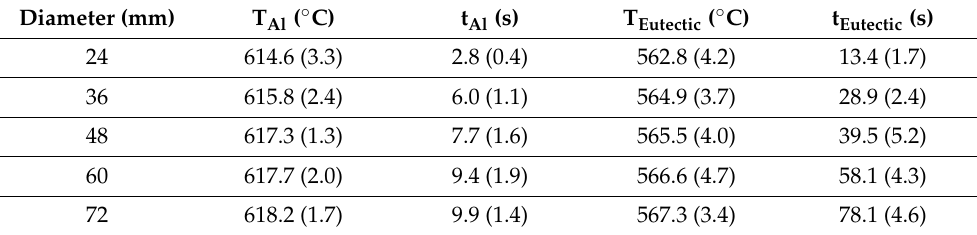
Table 4. Average values of the solidification parameters determined from the cooling curves (standard deviation values are shown between brackets).